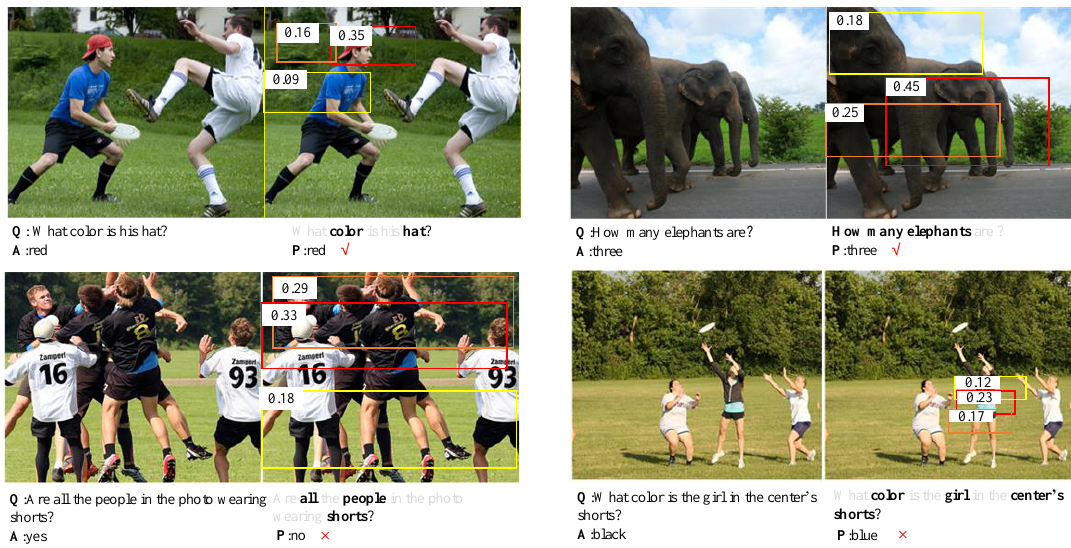
Figure 6. Typical examples of the learned image and question attention. The ( top row ) shows two examples of the correct prediction while the ( bottom row ) shows two incorrect predictions. For each example, the image, question (Q), answer (A) and prediction (P) are displayed in turn, followed by the learned image and question attentions. The brightness of the text and the score of the object proposal box represent the corresponding attention